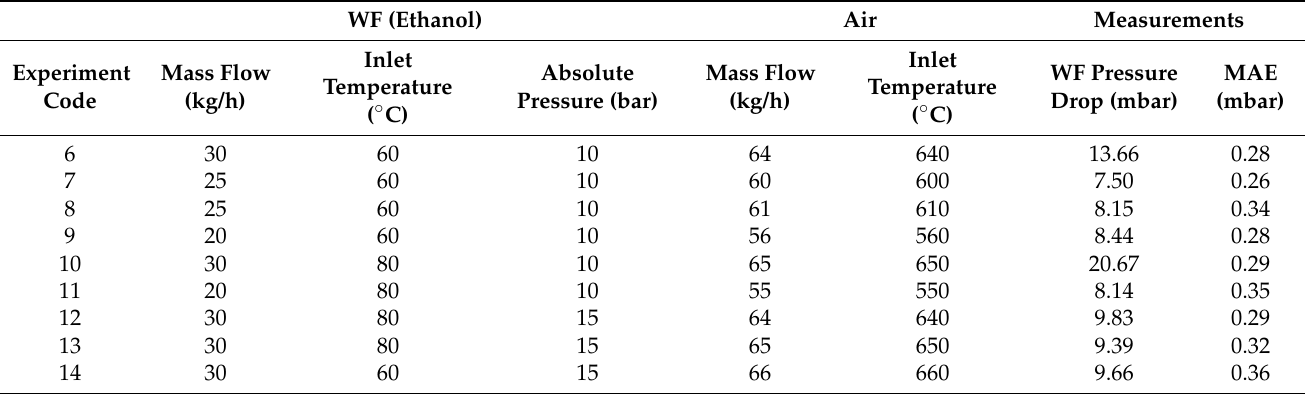
Table 2. Set of multiphase experiments of the boiler in operating conditions. WF (Ethanol) Air